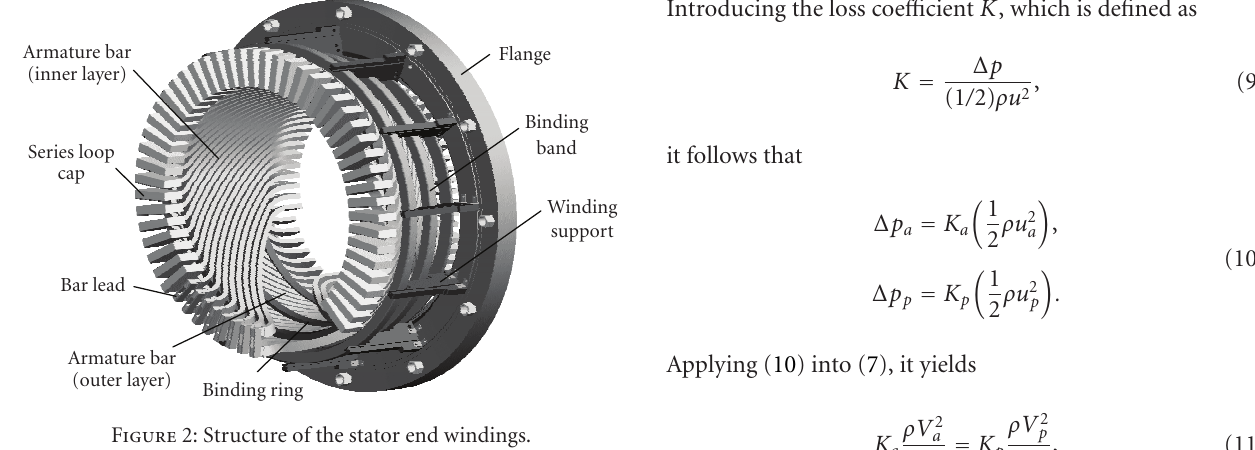
Figure 2: Structure of the stator end